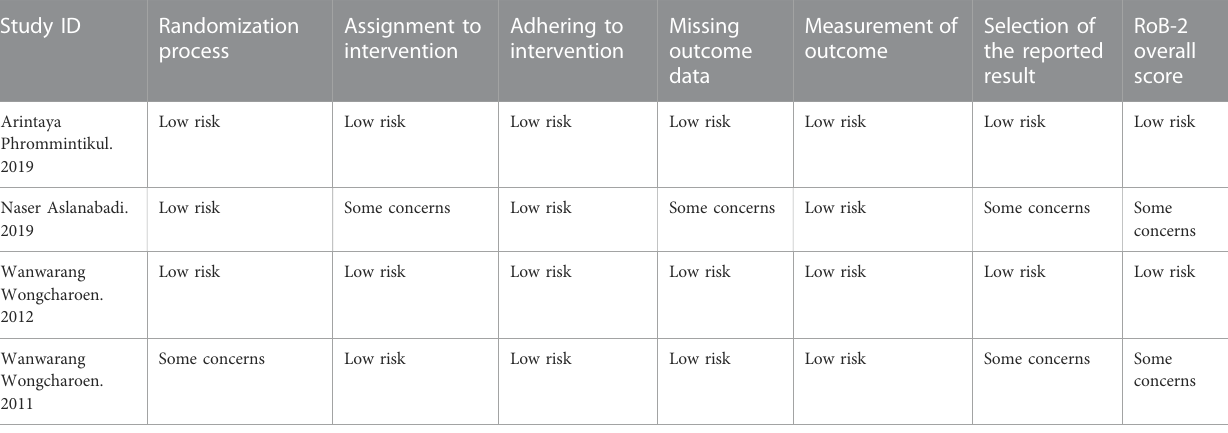
TABLE 4 Methodological quality of included human studies (RoB-2 tool). Study ID Randomization